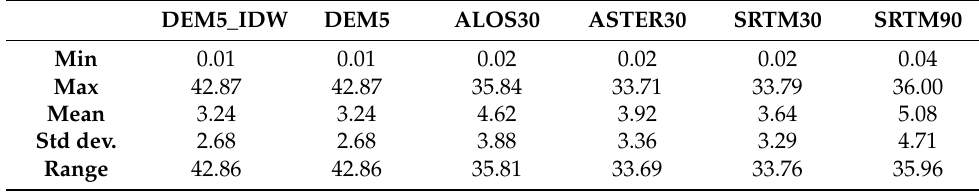
Table 8. The descriptive statistics of the LS values (CAL method) for all DEM.